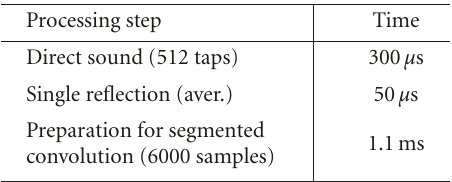
Table 3: Calculation time of several parts of the filter.